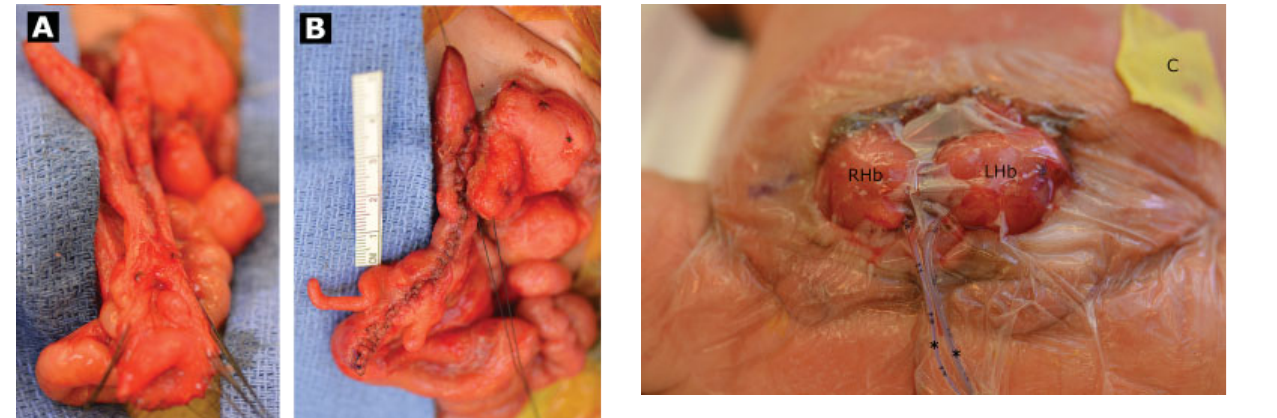
Fig.4 Postoperativeappearance of fi rst stage closure. The cecal plate has been tubularized and internalized, allowing uni fi cation of the bladder halves (RHb and LHb). Stents ( (cid:1) ) are left in each ureteral ori fi ce, and the bladder is covered with an occlusive dressing. colostomy